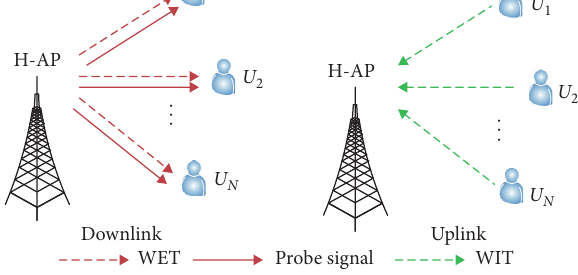
Figure 1: System model.